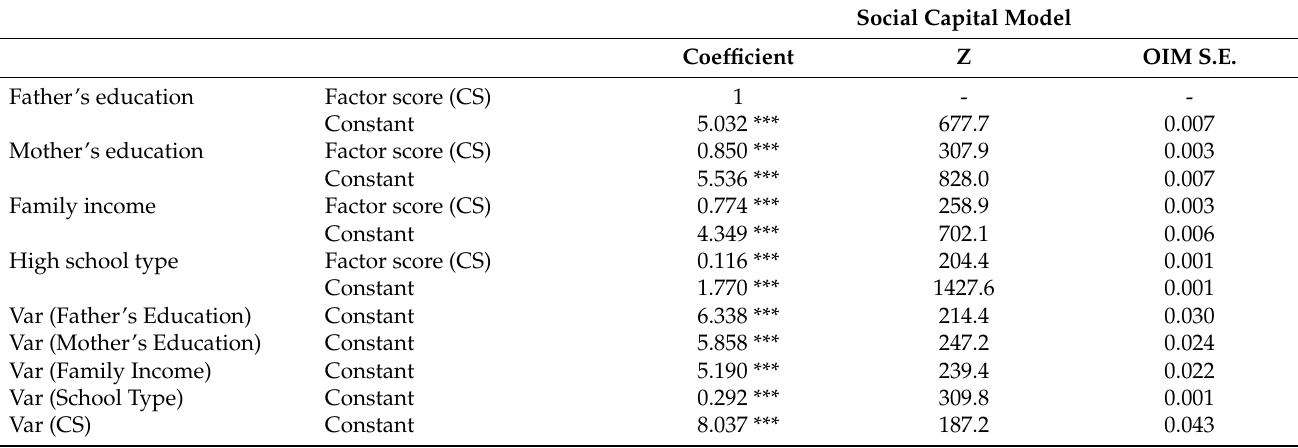
Table A3. Results for confirmatory factor analysis or measurement